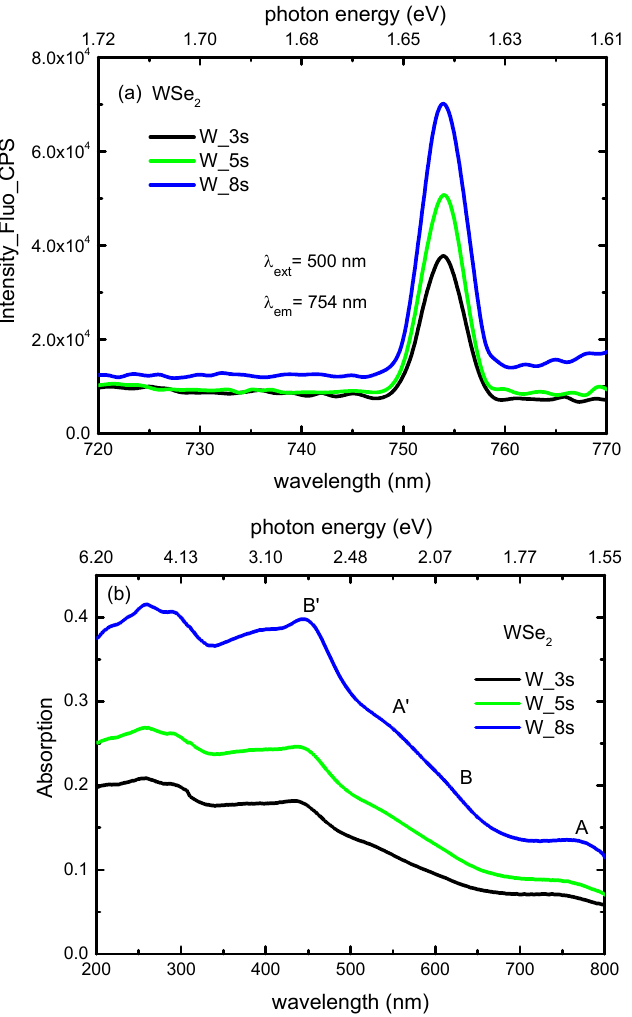
Figure 5. ( a ) Photoluminescence and ( b ) absorbance spectra of WSe 2 layers on fused